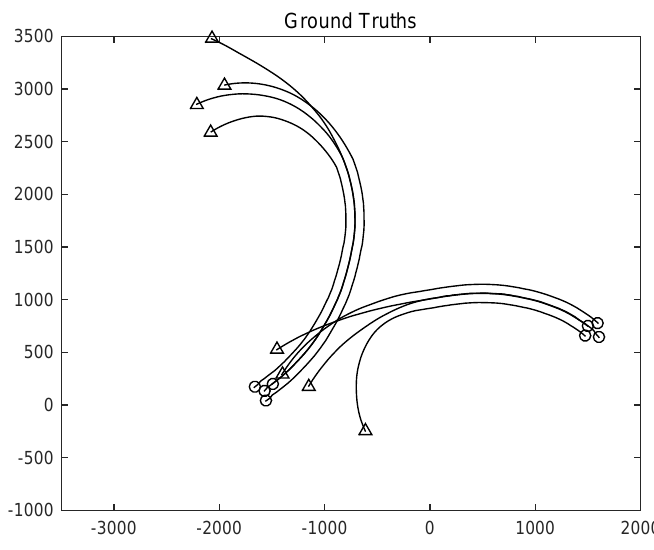
Figure 12. The tracks of group targets for experiment 2.